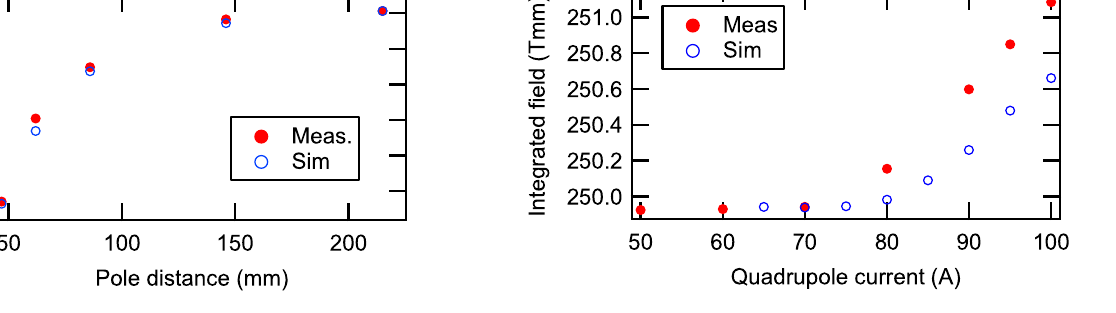
FIG. 6. Integrated field of a DL1 high field dipole and quadrupole assembly versus quadrupole current at 47 (cid:2) 1 mm pole distance. An offset was added to make the data equal at low current. The repeatability of the measurements was estimated to be (cid:2) 0 . 01% . The discrepancy between the measurement and the simulation comes probably from the magnetization curve used for the computations.